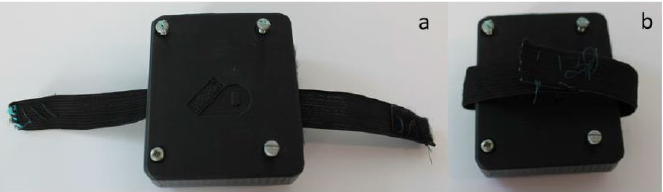
Figure 17. 3D-printed enclosure with elastic straps to fit child’s ankle. ( a ) Front, ( b ) Back.